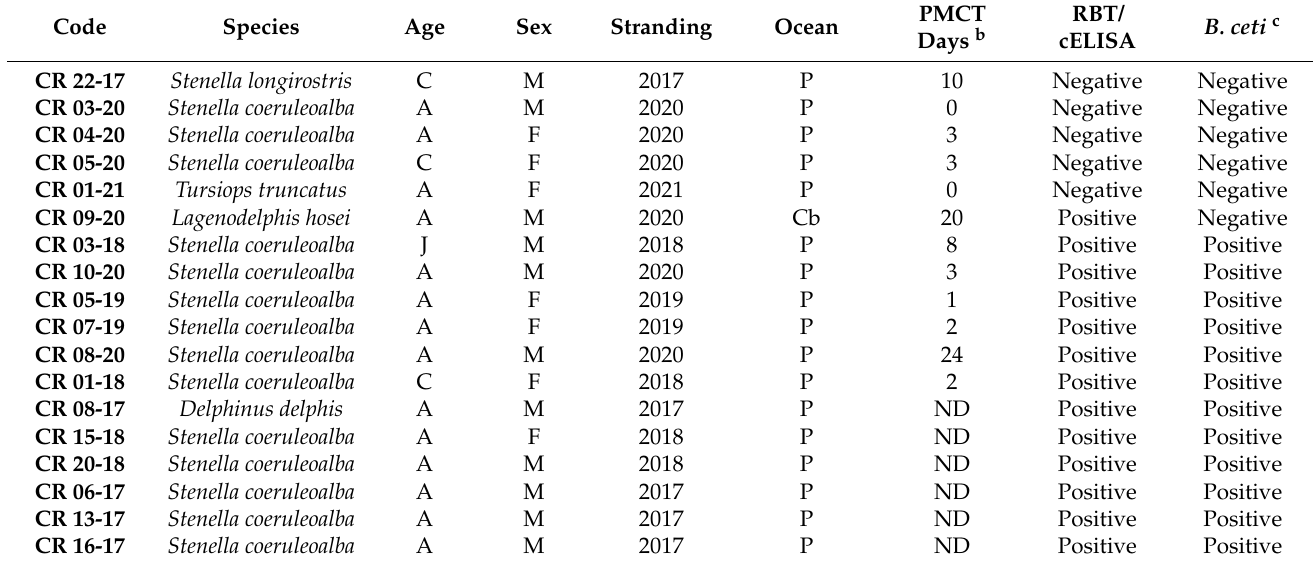
Table 1. Characteristics of the dolphins included in this study a